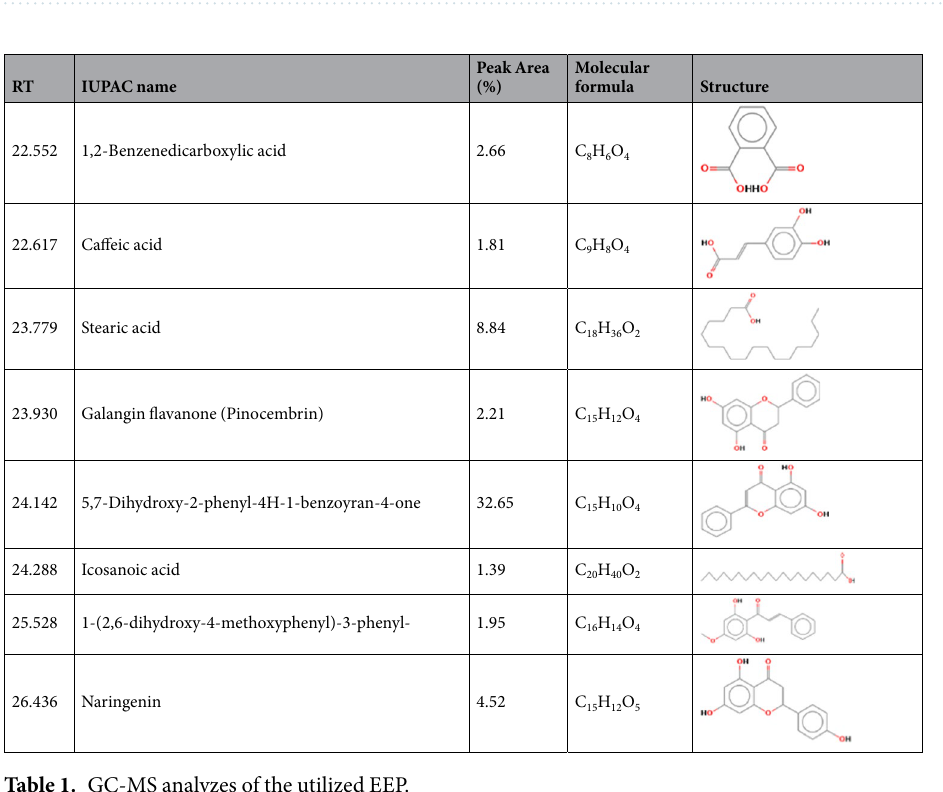
Figure 3. The chromatogram of the EEP according to GC–MS analysis. The figure displays the full-length chart with no cropping.